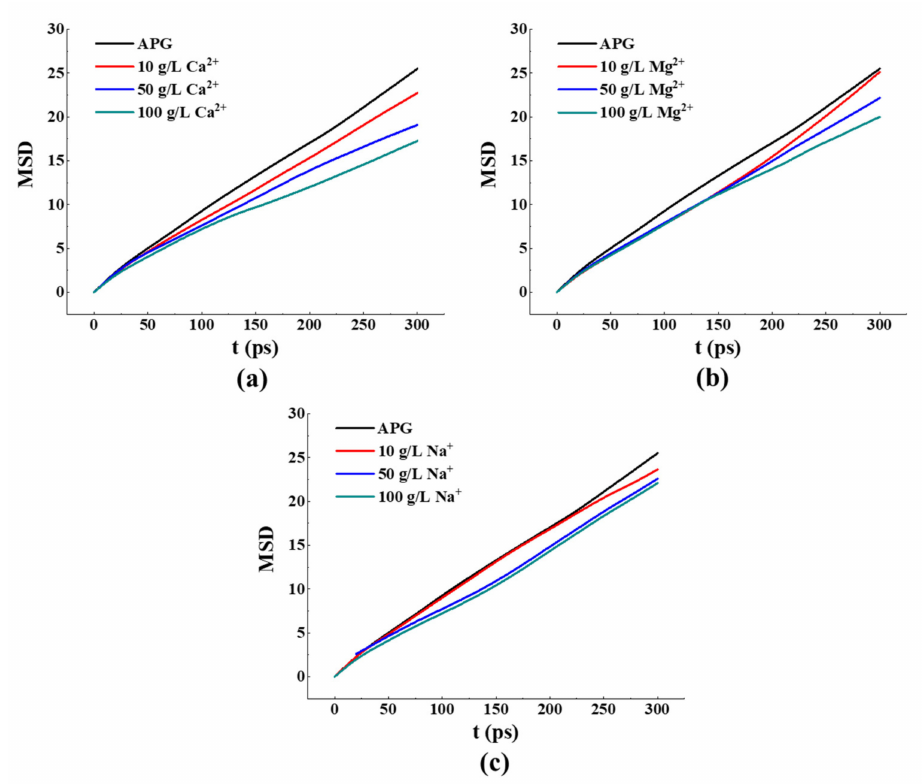
Figure 14. MSD of water molecules in the head groups hydration layer in different APG foams. ( a ) APG with CaCl 2 , ( b ) APG with MgCl 2 , ( c ) APG with